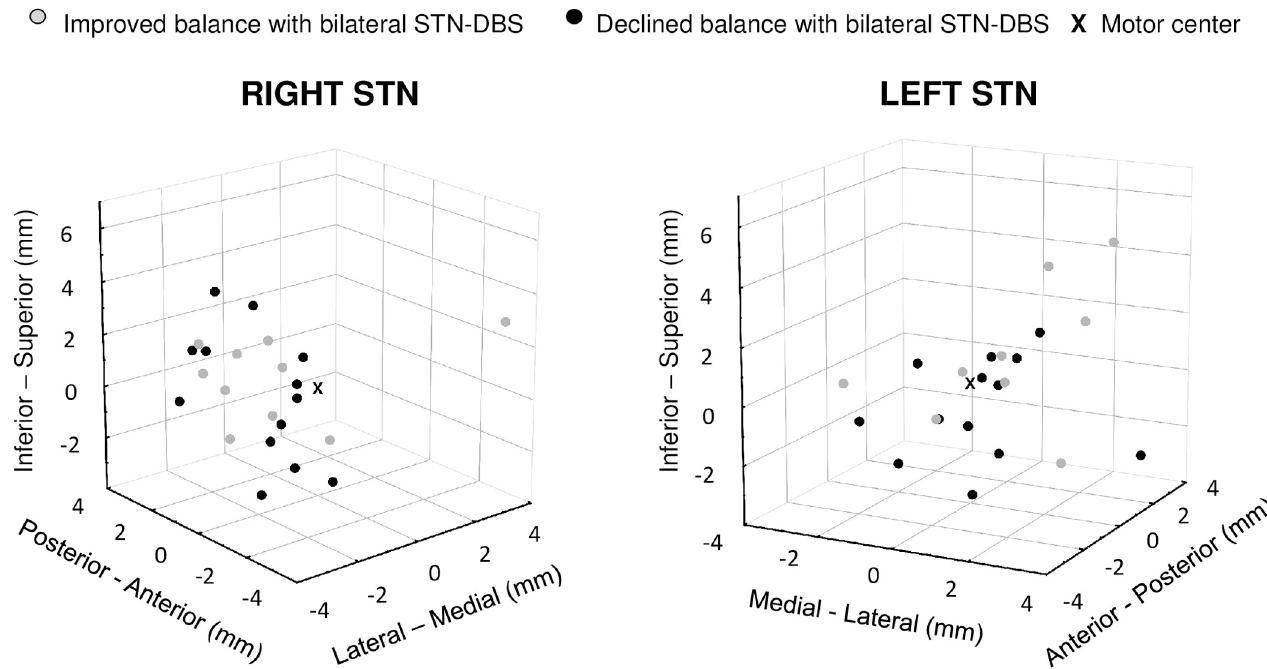
Fig 4. Active contact locations plotted relative to the center point of the dorsolateral STN. The active contact locations (median values in the right STN: x: 0.58mm, y: -1.81mm, z: 0.61mm; left STN: x: 0.57mm, y: -1.05mm, z: 0.67mm) are presented; where x axis represents medial-lateral, the y axis the anterior- posterior, and the z axis the superior-inferior plane. Locations are presented in grey colour if they belong to patients with improving balance when switching bilateral STN DBS on, and in black in case of bilateral STN DBS-induced imbalance. The center point of the dorsolateral STN as the point of reference is indicated with an asterisk in the coordinate